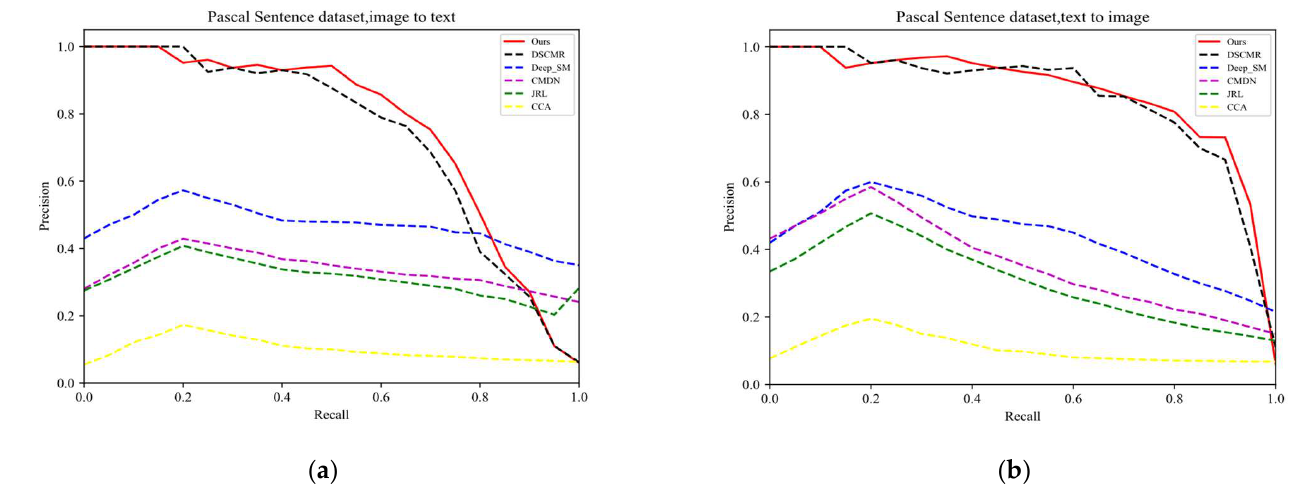
Figure 10. The PR curves of the cross-modal retrieval performance on the Pascal Sentence dataset. ( a ) The image to text task on the Pascal Sentence dataset. ( b ) The text to image task on the Pascal Sentence dataset.